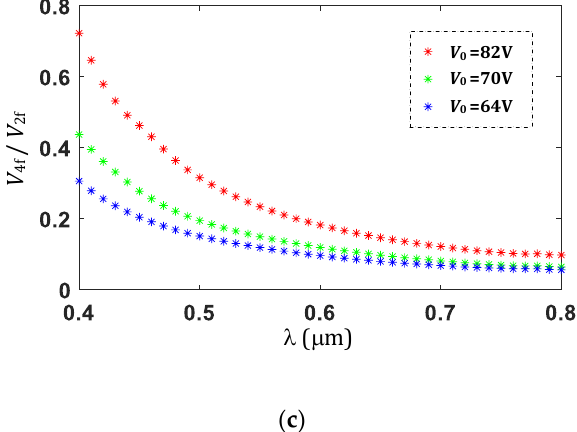
Figure 3. Modulation signals and the ratio of multiple harmonic components. ( a ) Waveform as shown on the oscilloscope at λ = 0.4 μ m; channel V represents the driving voltage signal, with a peak driving voltage of 164 V (with amplitude of V 0 = 82 V), and channel I is the modulation signal, with a peak value of 13.2 mV; ( b ) ratio of the second and forth harmonic components in the experiment, where the wavelength of the incident light was increased by 10 nm increments for about 4.5 s, from 0.4 μ m to 0.8 μ m; ( c ) mean value of the ratio of the second and forth components varied in the wavelength range of 0.4 – 0.8 μ m, obtained by the averaging of the ratios shown in (b) for every light wavelength.